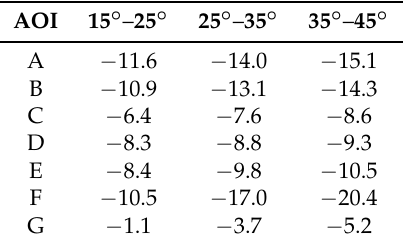
Table 2. Estimated ¯ σ 0 in dB for each AOI and different ranges of θ